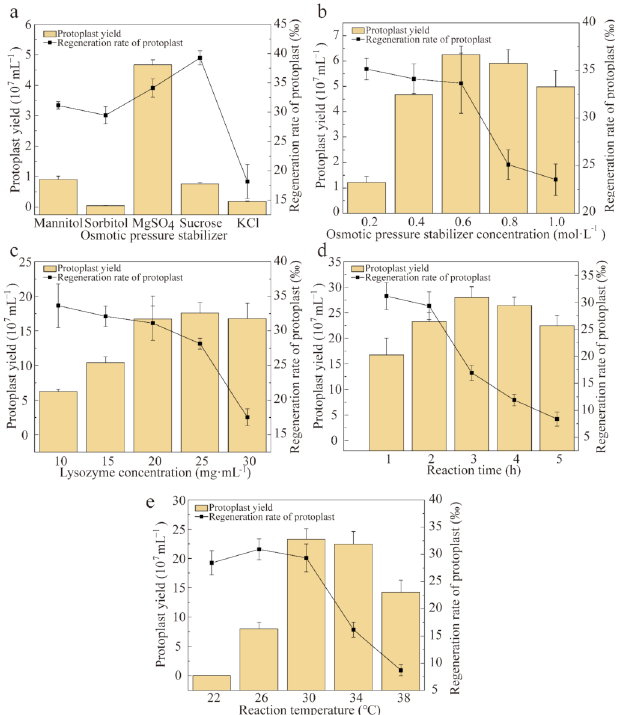
Figure 2. Protoplast preparation and regeneration under different reaction conditions. ( a ) Osmotic pressure stabilizers; ( b ) MgSO 4 as the osmotic pressure stabilizer; ( c ) lysozyme con- centration; ( d ) Rreaction time; and ( e ) reaction temperature. The protoplast yield and regeneration rate were determined for each reaction condition.